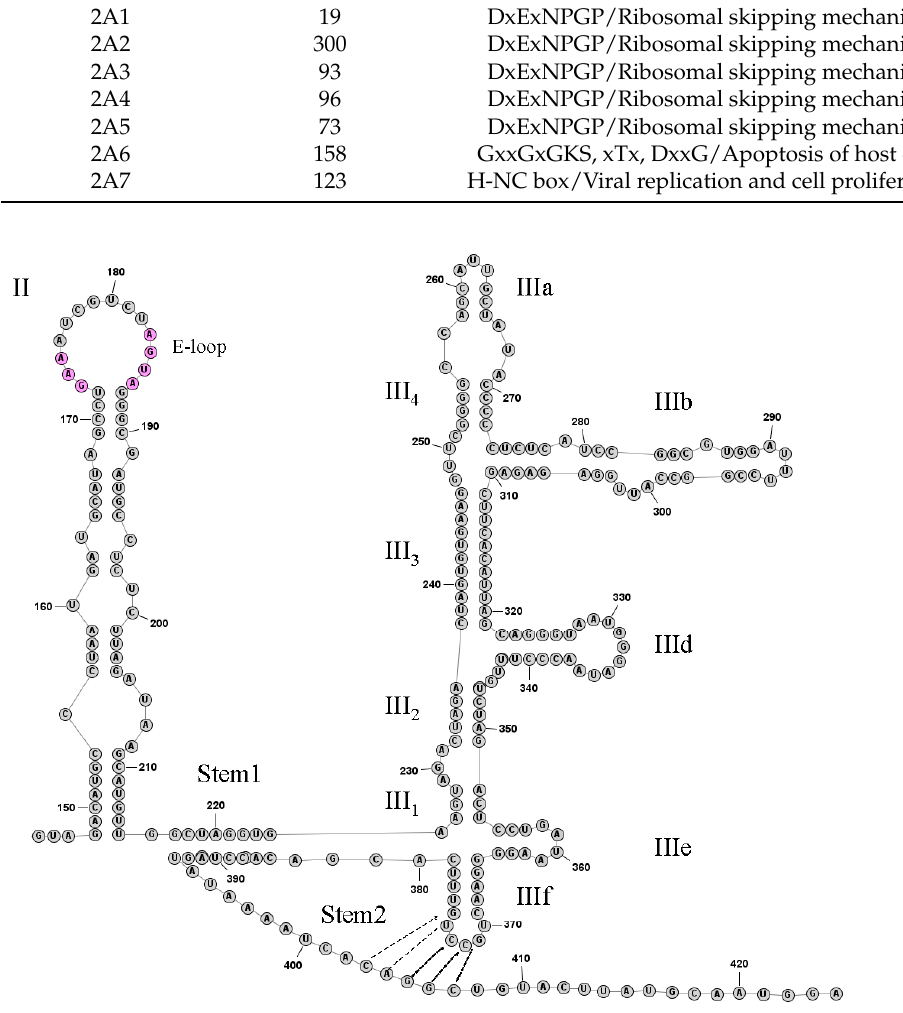
Figure 3. Predicted secondary structure of the DERSV IRES. Domains II and III are labeled according to corresponding domains in the type IV IRESs [14]. In domain III, individual helical segments are labeled III1 and III2, etc.; and individual hairpins are labeled IIIa and IIIb, etc. The pseudoknot stem 1, stem 2 and domain IIIf helix are labeled.